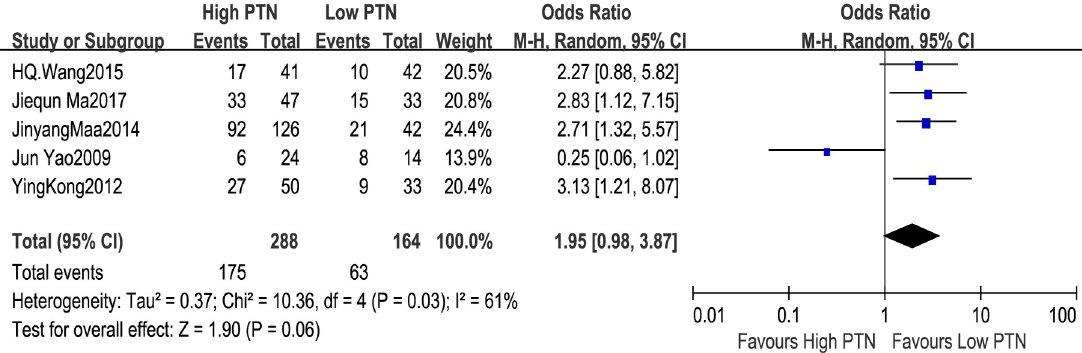
Fig 5. A forest plot for the association between the PTN expression levels with histological grade. The expression of PTN was independent of histology grade.